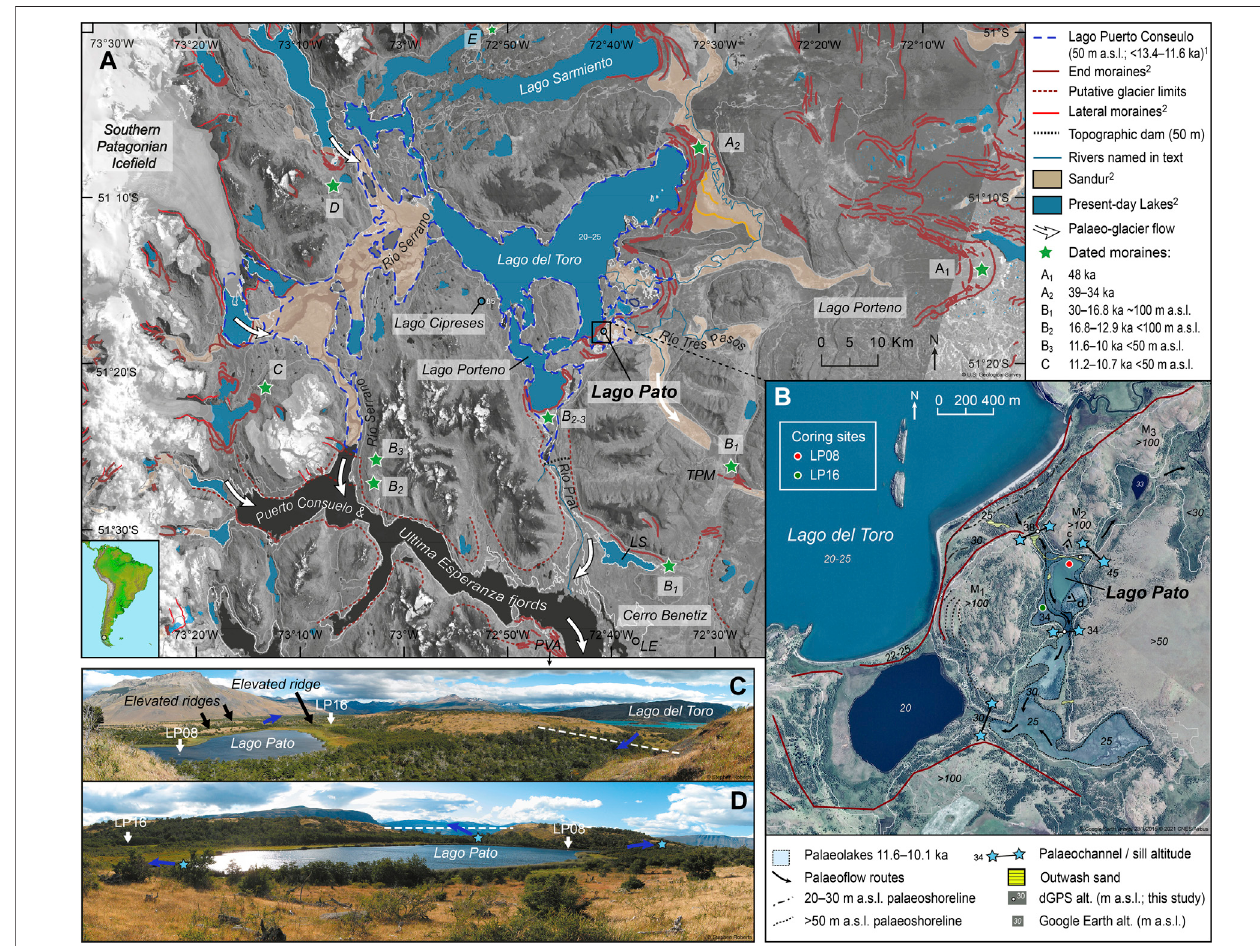
FIGURE 2 | (A) Location map highlighting key geomorphological features in the Torres Del Paine region [based on data in Glasser et al. (2008)]. The 50 m a.s.l. contourisshownasadottedblueline.Greenstarssummarisetheextentandageofformerregionalglaciations.1,Garciaetal.(2014);2,Glasseretal.(2008).Attribution: LANDSAT-8 satellite image was superimposed on the GEOTOP30 DEM in ARC-Map (www.esri.com), courtesy of the U.S. Geological Survey (https://www.usgs.gov/ centers/eros). (B) Summary geomorphological sketch showing the ~40 m a.s.l. palaeoshoreline of Lago Pato and fl ow pathways and retaining ridges that would isolate Lago Pato from Lago del Toro (blue stars) as follows: 1) in the wetland to the south, separated by a sill elevation of 33.4 ± 0.1 m a.s.l.; 2) at 38.0 ± 0.1 m a.s.l., throughagap fi lledwithoutwashsanddeposits betweentheprominentmorainecomplexthatrunsparallelwiththesouthernshoreofLagodelTorotothenorthwest;3) out fl ow breaching the northeastern sill at ~40 – 45 m a.s.l., requiring more substantial lake level rise of > 10 m. Once the lake level in Lago del Toro dropped below ~40 – 38 ma.s.l.,theonlydrainageroutefromLagoPatowastothesouth,overthesouthernsillat~32 ma.s.l.intotheadjacentlakeandLagodelToro(~20 – 25 ma.s.l.). AreastothesouthandsoutheastofLagoPato,mappedassandursbyGlasseretal.(2008),werevisitedduringcoringandinterpretedastemporarywetlandsthatdryup duringsummer.LSisLagoSo fi a,LEisLagoEberhard, TPMisTresPasosMoraine,andPVAisPantanoAntonioVaras.Attribution: GoogleEarth,©Google.com,image 23/1/2015 © 2021 CNES/Airbus. (C) View from the northern side of Lago Pato showing the coring sites LP08 and LP16 and meltwater channels cut through the elevated moraine ridges on the NW and SE shores. (D) View looking towards the NE ridge and meltwater channel from the southern side of Lago Pato.